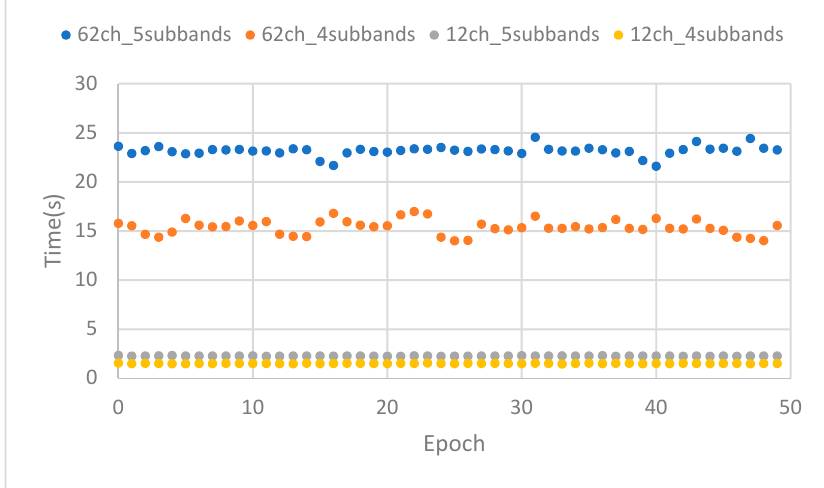
Figure 6. Time overhead comparison graph.